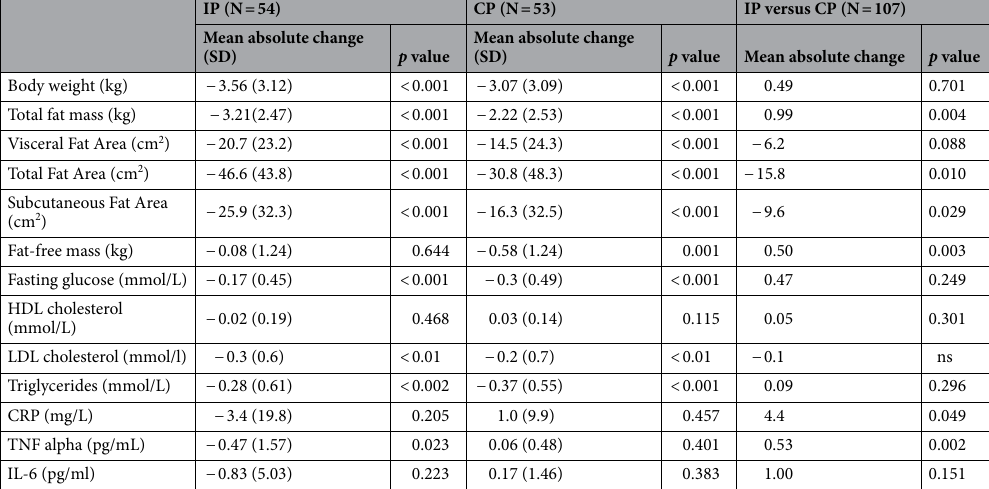
Table 3. Between-group differences in absolute changes in body composition from baseline to Week 12 in the FAS Population (N = 107). Mean values (standard deviation); Between group difference denotes IP effect versus